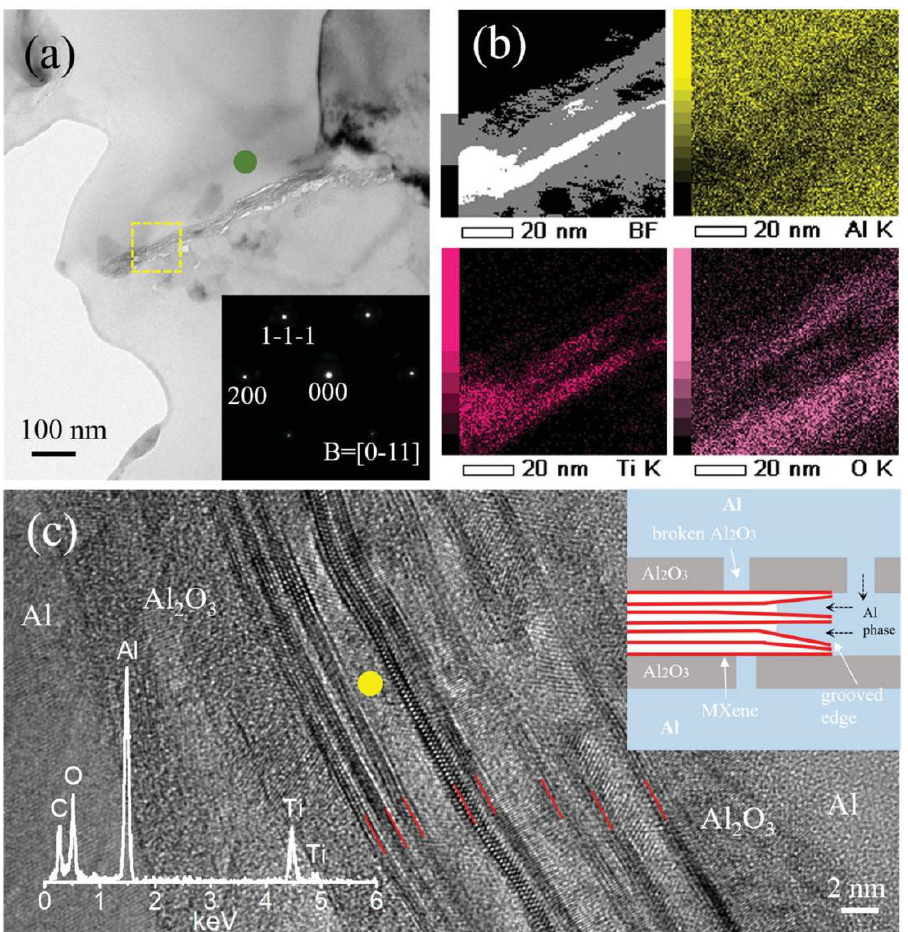
Figure 12. ( a ) TEM image of a 0.26 vol.% FLM/Al composite in the longitudinal cross-section; ( b ) ABF-STEM image and corresponding EDS maps of elemental Al, Ti, and O taken from the yellow square in ( a ); ( c ) HRTEM image of the FLM-Al interface. Inset in ( a ) shows the SAED pattern of Al taken from green spot. Insets in ( c ) show the EDS analysis taken from the yellow spot, and the schematic of the Al filled into the grooved edge of the FLM, respectively. Reprinted with permission from [68]. Copyright 2020 Taylor and Francis.